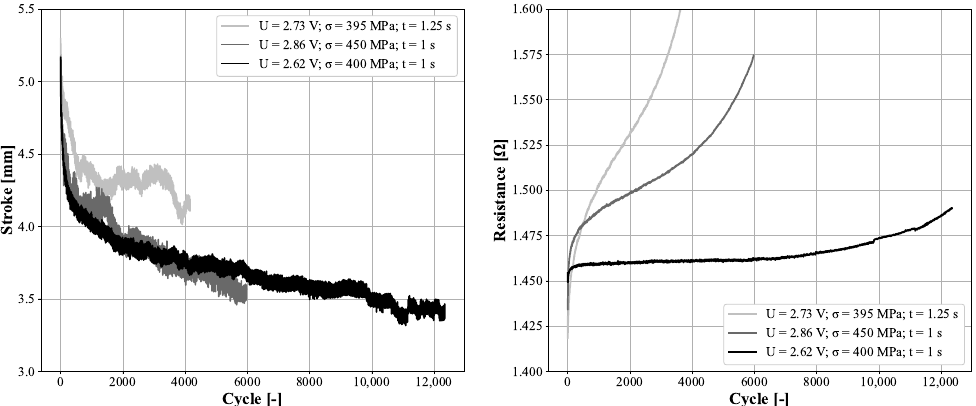
Figure 1. Stroke [mm] ( Left ) and electrical resistance [ Ω ] ( Right ) over cycles [-] for various load sce- narios. Source: